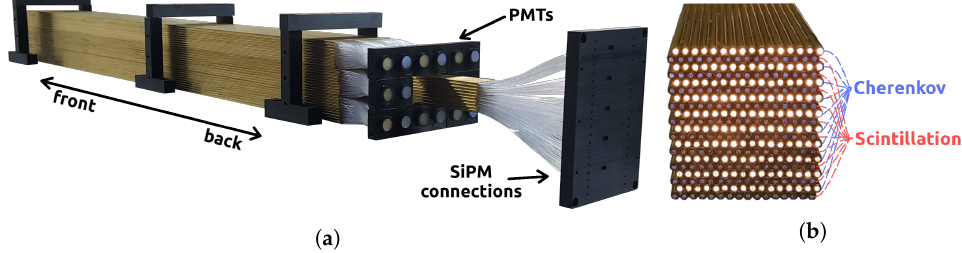
Figure 1. Dual-readout calorimeter prototype built for testbeams [5]. ( a ) The full prototype with